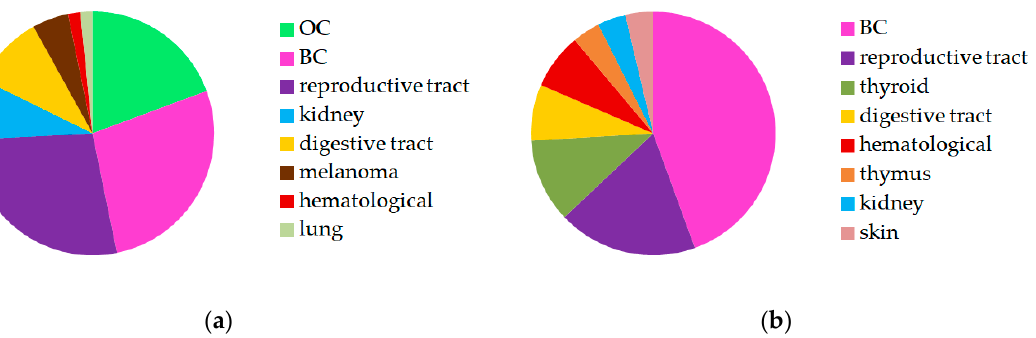
Figure 1. The other invasion sites: ( a ) in patients with BC; ( b ) in patients with OC. Three combinations per case are considered for triple primary malignancies.